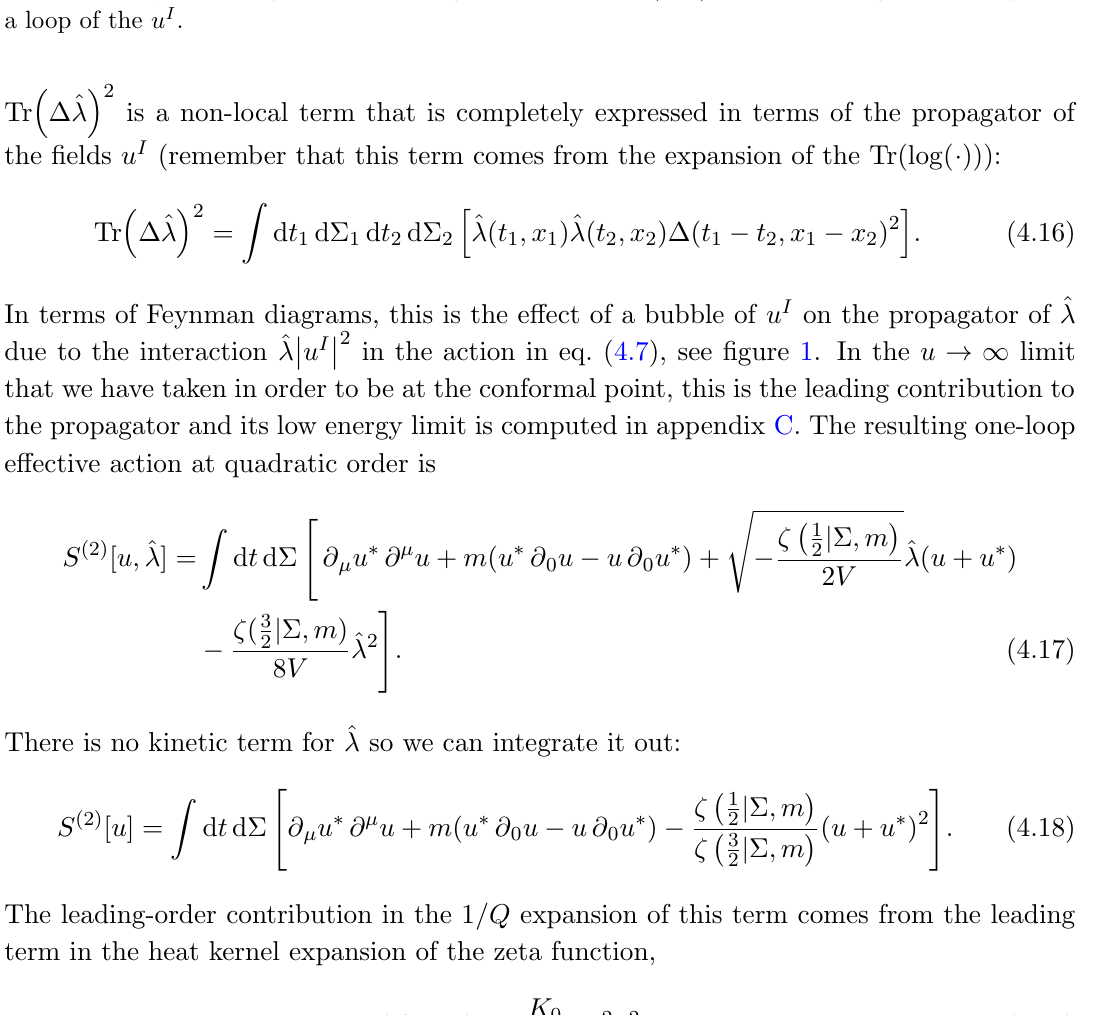
Figure 1 . Feynman diagram representing the correction B ( !; p ) to the ^ (cid:21) propagator coming from a loop of the u I